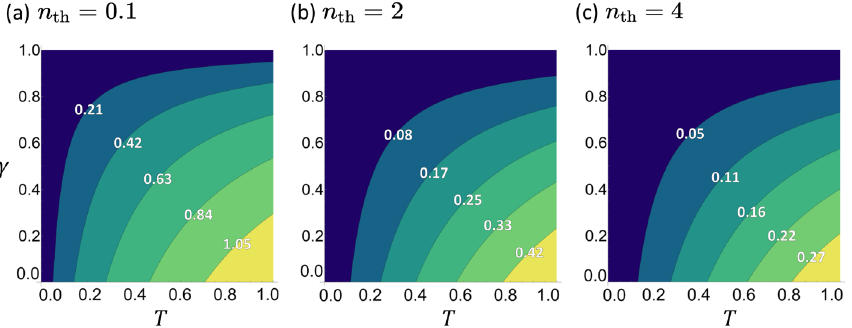
Figure 2. The SNR for the coherent state as a function of γ and T under photon counting scheme. The average 2 and the thermal photon number is n th input photon number is n = increases, (ii) γ decreases, and (iii) n th